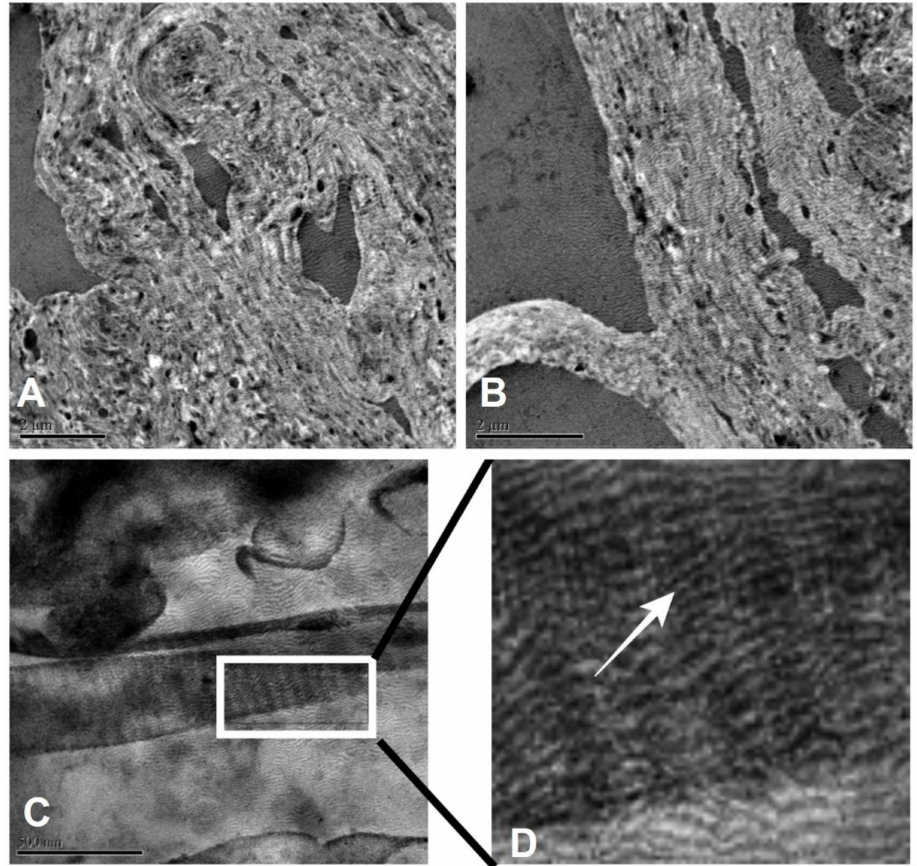
Figure 3. Type 1 collagen fibril microstructure observed by transmission electron microscopy. One can see the characteristic fibrillar pattern of type 1 collagen. Micrograph magnifications were 8000 10,000 ( B ), 8000 ( C ), and 25,000 ( D × × ×